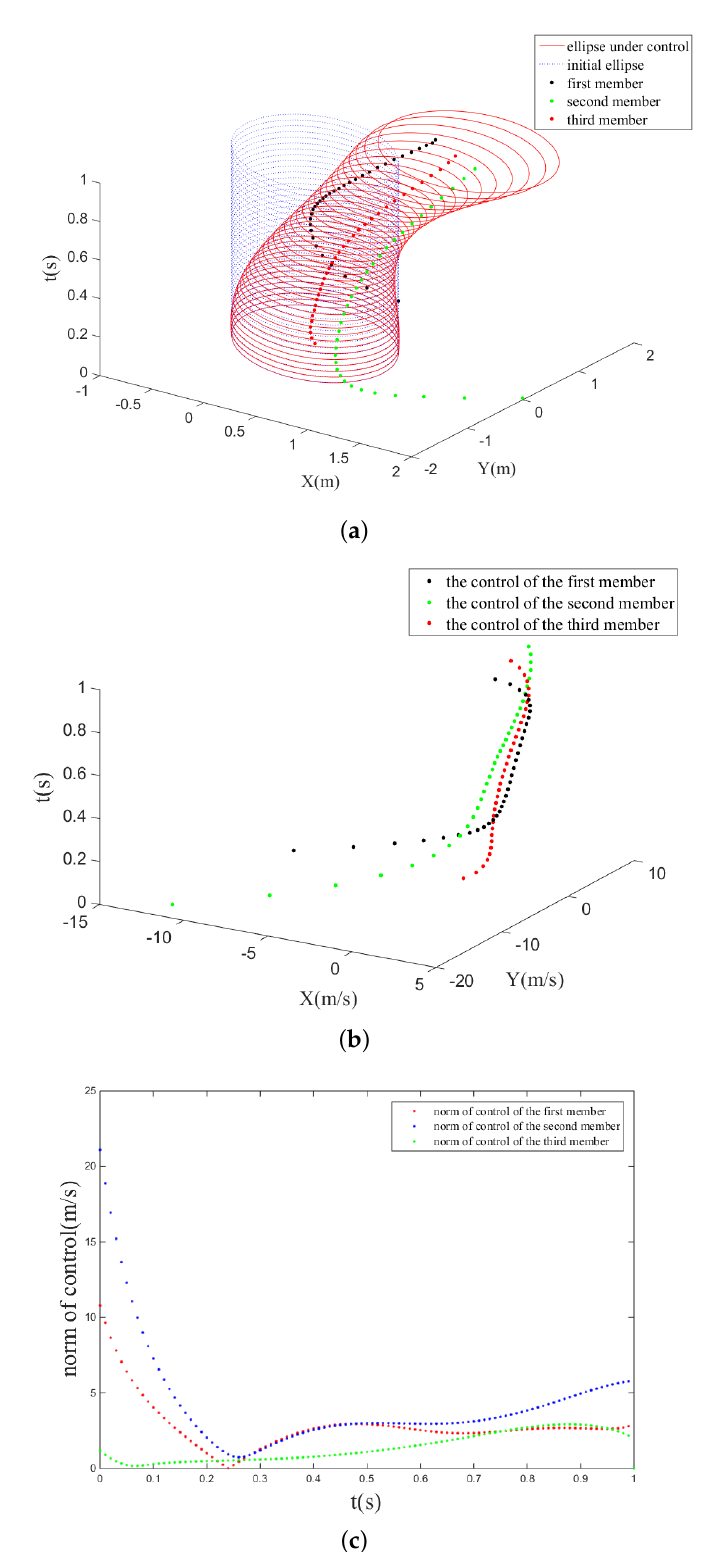
Figure 2. Team motion with initial states x 1 ( 0 ) = [ 0,1.5 ] , x 2 ( 0 ) = [ 2,0 ] , x 3 ( 0 ) = [ 0,0 ] and parameters ω = 0.1, β 1 = 5.87, β 2 = 5.88, β 3 = 5.85, κ 12 = 1.13, κ 13 = 1.15, κ 23 = 1.10. ( a ) The state-time relationship diagram of the cluster. ( b ) The control-time relationship diagram of the cluster. ( c ) The norm of the control-time relationship diagram of the